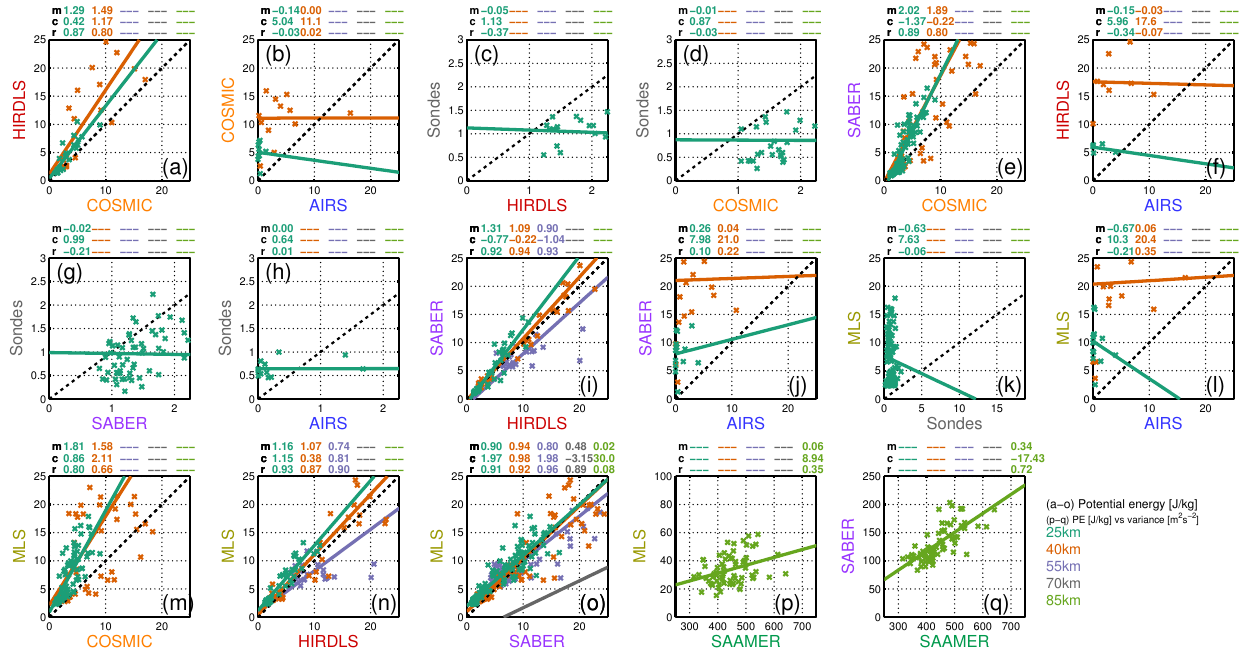
Figure 16. Scatter plots showing the agreement level between the monthly median GWPE measured by each pair of data sets. Data set pairs which do not overlap in altitude have been omitted. For panels (a–c, e–g) , the horizontal and vertical axes indicate the GWPE measured by each instrument at all overlapping height levels; the colour indicates the height level considered. The 1 : 1 line of perfect agreement is indicated by the black dotted line, whilst linear fits to the data at each height level are shown by the appropriately coloured line. Gradients [ m ] and Pearson correlation coefficients [ r ] for each level are indicated above the corresponding panel. Panel (d) uses the same format, but values shown are normalised to the distribution mean for each instrument due to the different physical quantities under